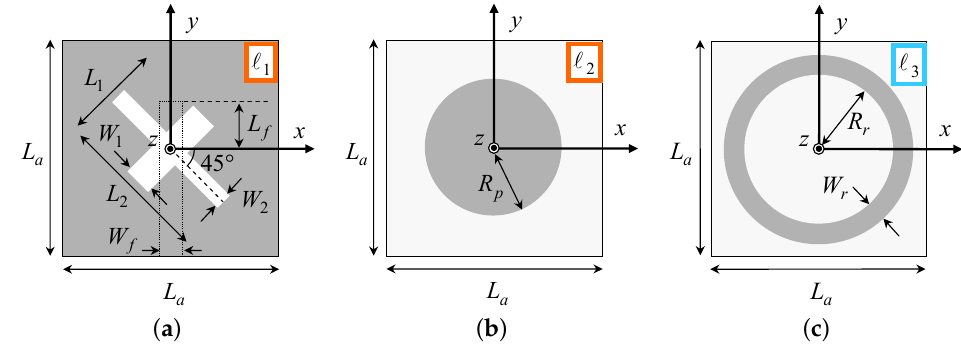
Figure 2. WWCS Antenna Layout —top-view geometry sketches of layers ( a ) (cid:96) 1 , ( b ) (cid:96) 2 , and ( c ) (cid:96) 3